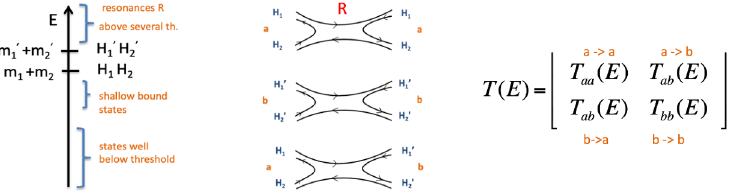
Figure 3. A resonance that decays via two channels R → H 1 H 2 , H (cid:48) scattering of two coupled channels.